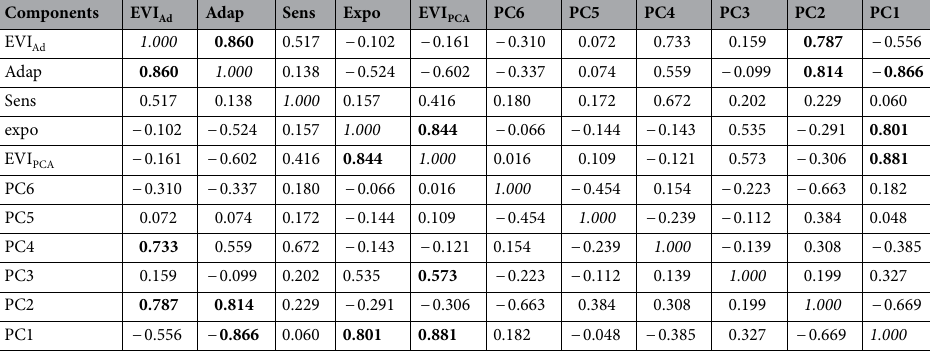
Table 5. Pearson correlation coefficient. Note EVI Ad = additive ecological vulnerability index,